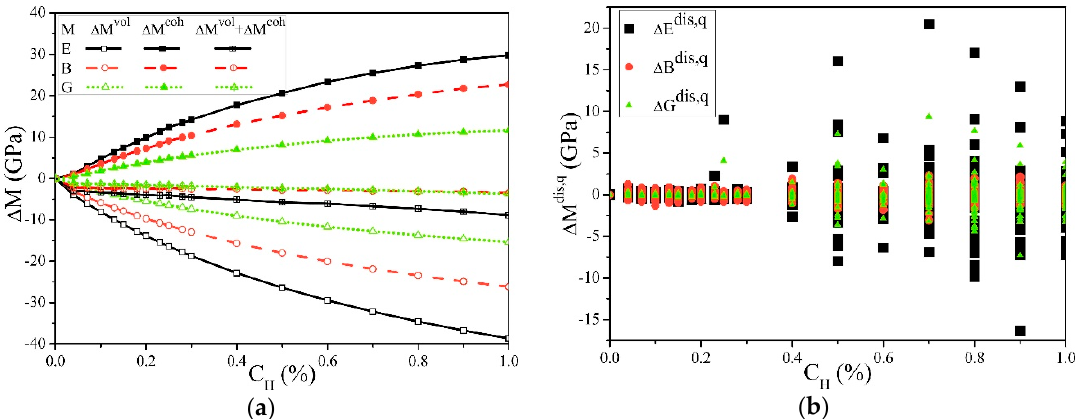
Figure 3. Solute hydrogen atom effects on the elastic moduli of the α -Fe single crystal. ( a ) Averaged elastic moduli changes. This shows that Young’s modulus E, the bulk modulus B, and shear modulus G were all slightly decreased by the hydrogen solution, which is a combination of the decrease by volume and the increasing by cohesion. ( b ) The hydrogen distribution influences on the moduli in each structure, which indicates that the slight differences in the microscopic distribution of hydrogen atoms might cause different effects from the averaged results.